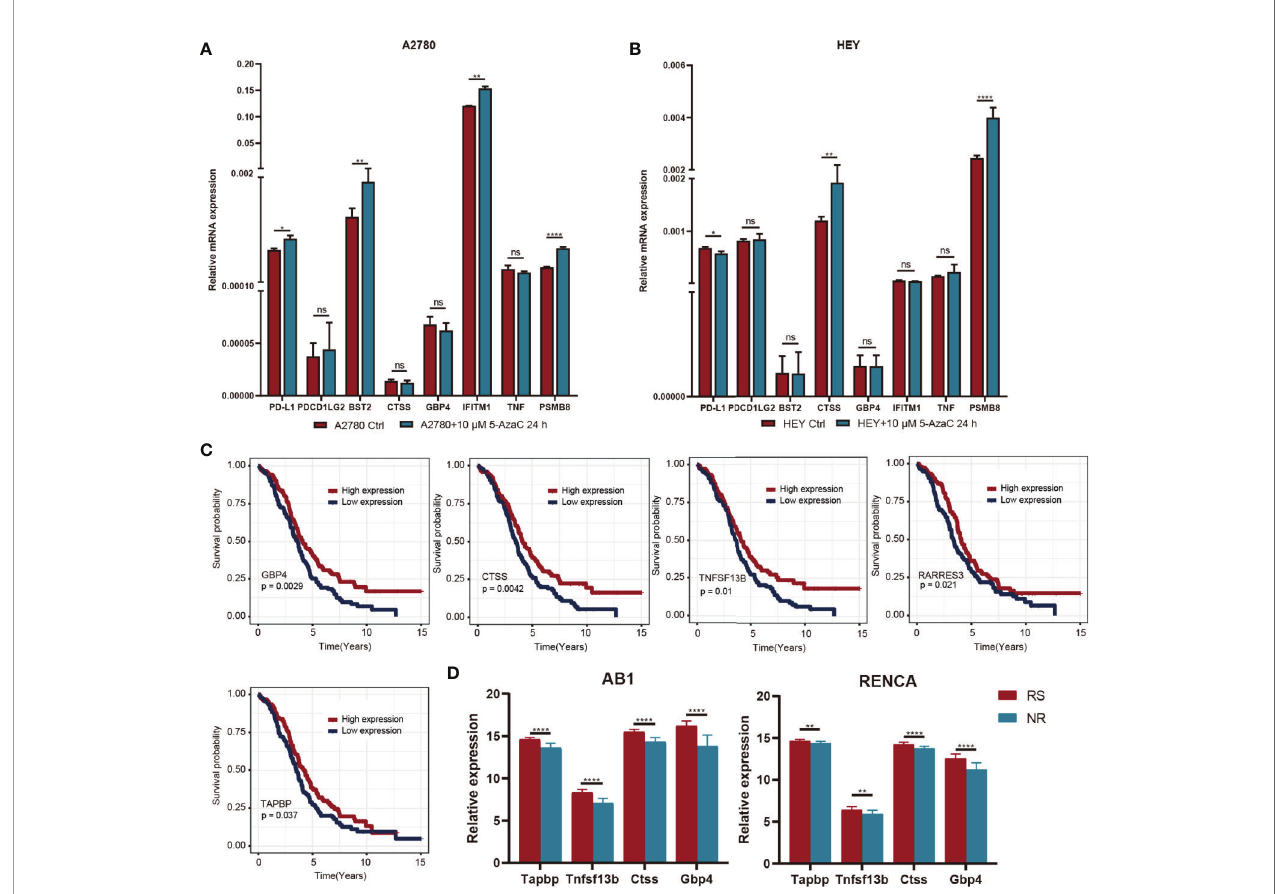
FIGURE 9 | (A) After A2780 cell lines were treated with 5-AZ at the concentrations of 10 m M for 24 hours, the changes of gene expression levels were observed. (B) After HEY cell lines were treated with 5-AZ at the concentrations of 10 m M for 24 hours, the changes of gene expression levels were observed. (C) K-M survival curve of differentially methylated genes associated with prognosis. (D) Relationship between prognosis related differential methylation genes and immunotherapy responsiveness. *P < 0.05, **P < 0.01, ****P < 0.0001, and ns, ‘ No Signi fi cant ’